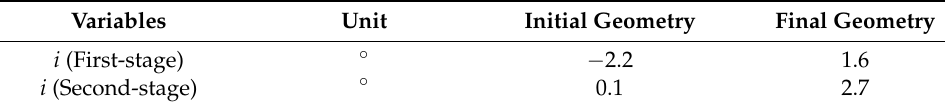
Figure 18. Streamline of the final geometry. Table 9. Incidence angles of the rotor blades.